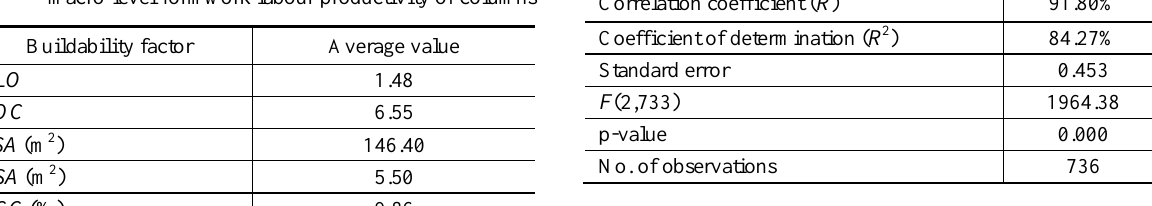
Table 3. Average values of buildability factors influencing macro-level formwork labour productivity of columns